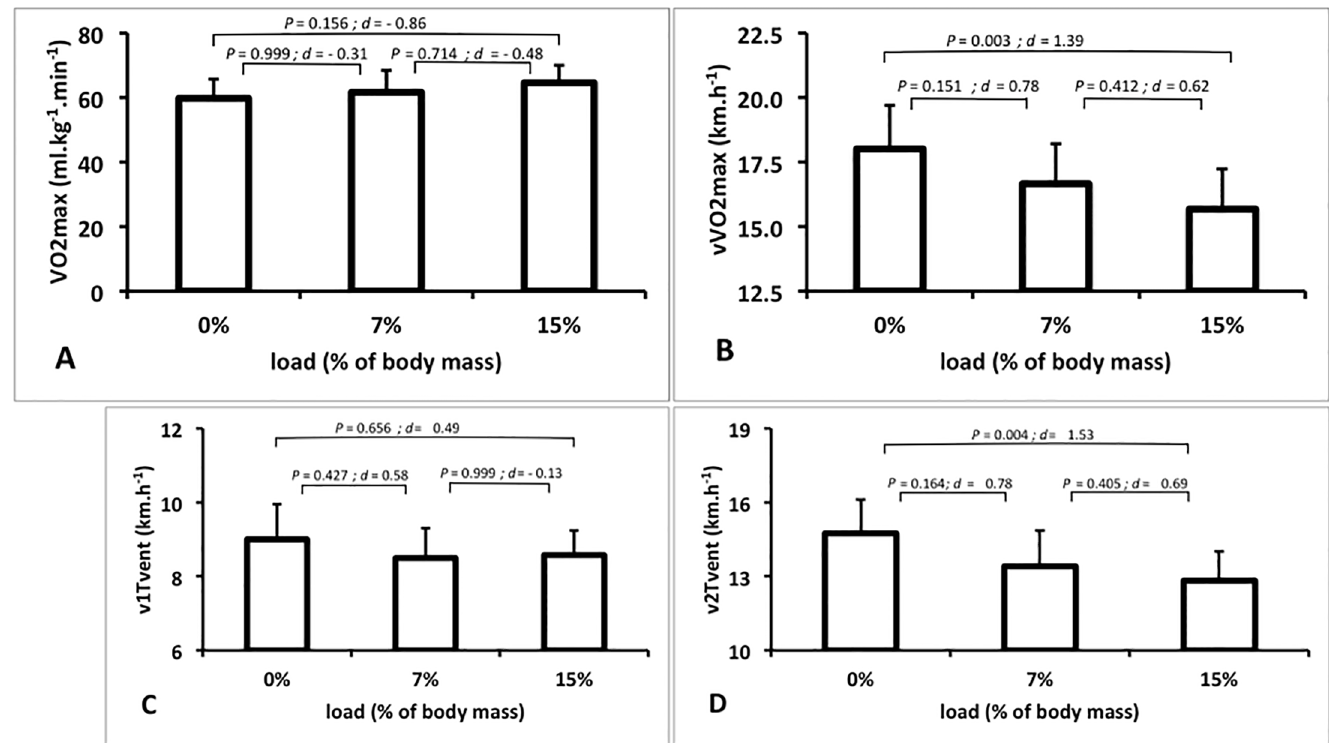
Fig 2. Mean and standard deviation of VO2max (A), velocities associated with VO2max (vVO2max, B), first (v1Tvent, C) and second (v2Tvent, D) ventilatory thresholds at different conditions (0%: unloaded; 7% of body mass; and 15% of body mass). P ’s and effect sizes (Cohen’s d ) are also